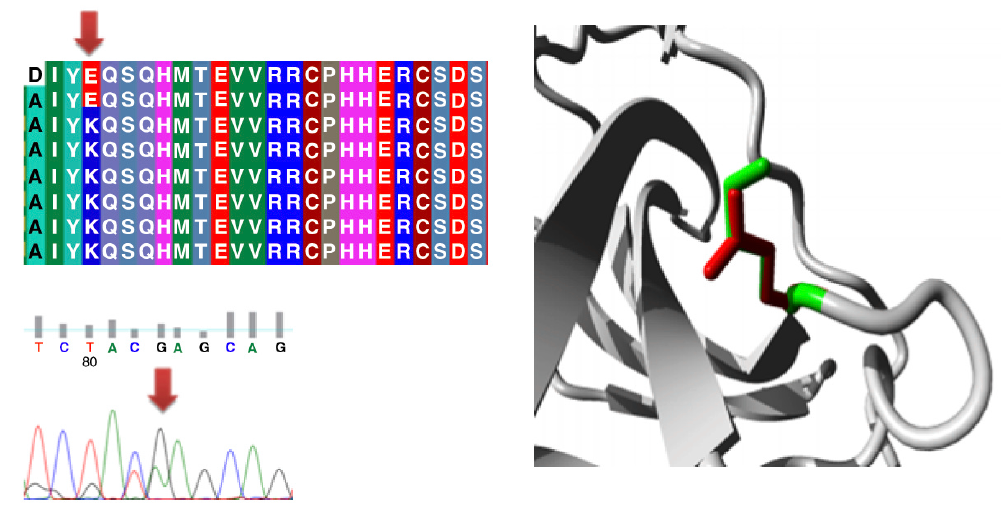
Figure 6. Mutation of lysine into glutamic acid at position 164.